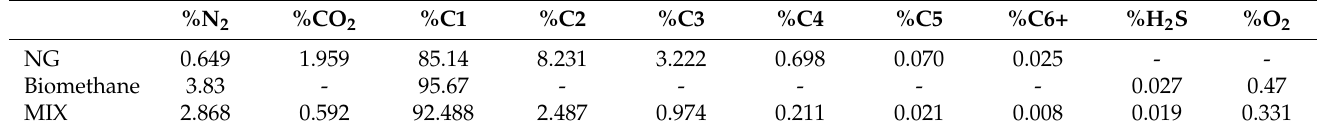
Table 2. LHV, WI and RATIO of average NG, average biomethane and MIX (X =